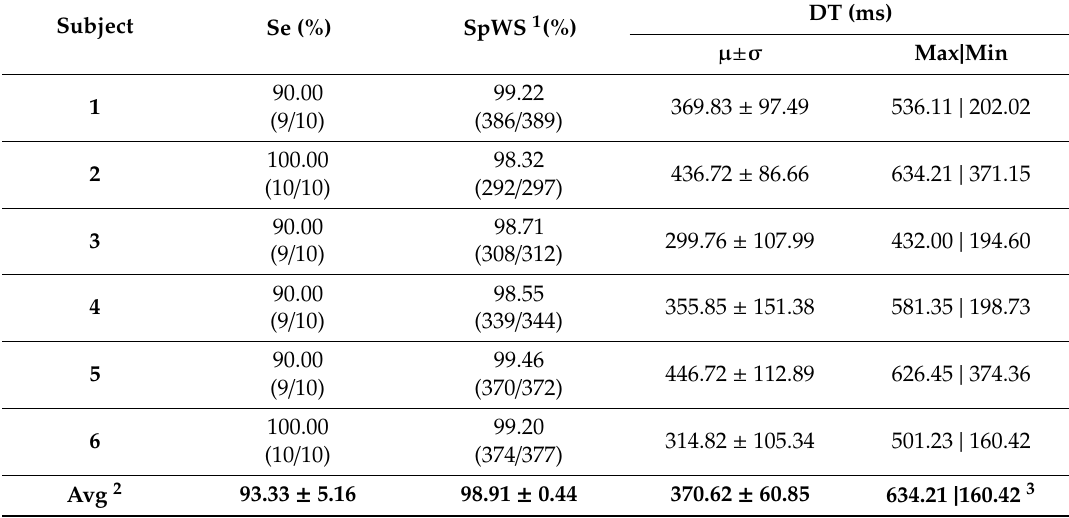
Table 2. Proposed architecture accuracy and e ffi ciency: near falls vs. steady